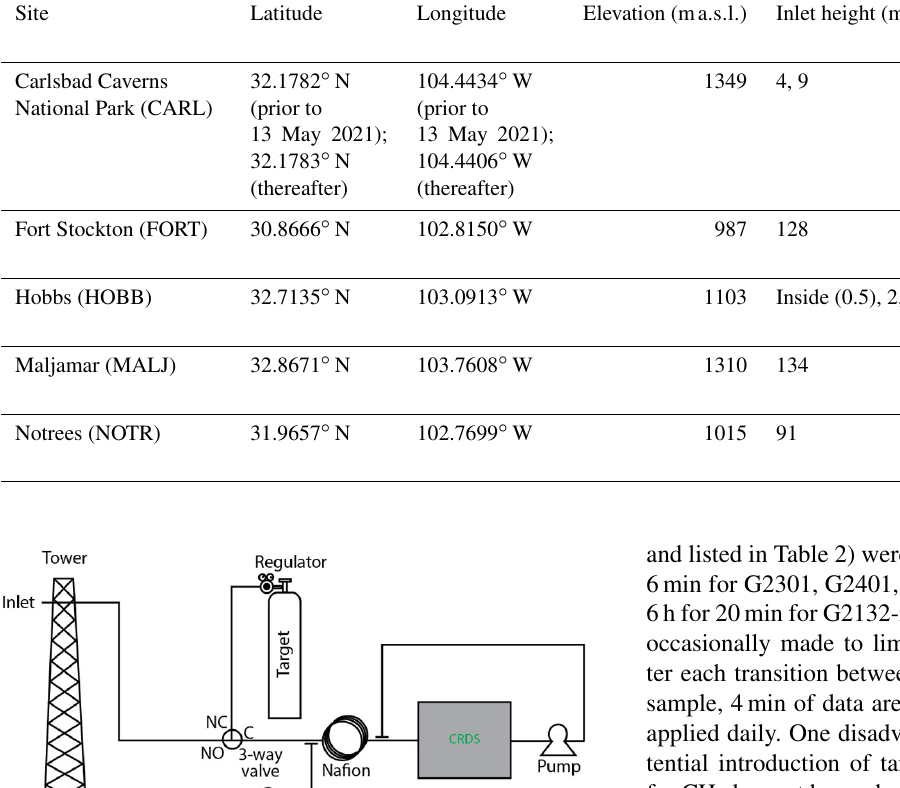
Table 1. Locations, inlet heights, species measured, and installation dates of in situ tower-based measurements in the Permian Basin. Site